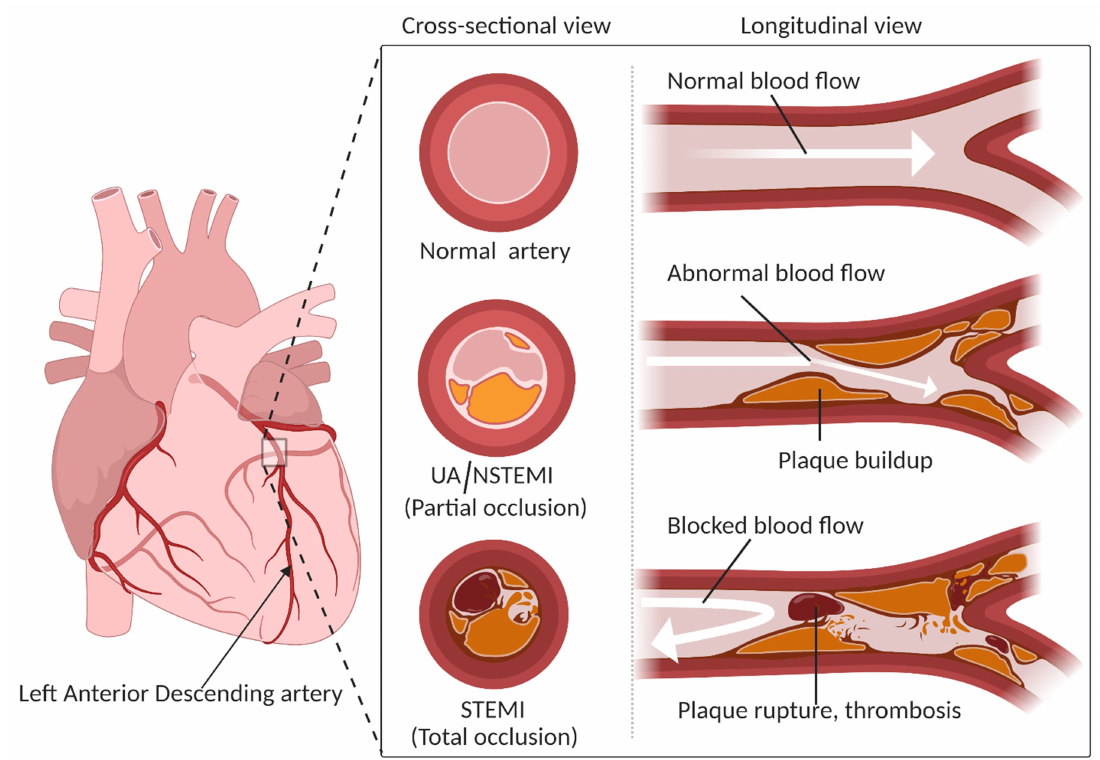
Figure 1. Classification of acute coronary syndromes. Acute coronary syndromes are categorized into unstable angina (UA), non-ST-segment elevation myocardial infarction (NSTEMI), and ST-segment elevation myocardial infarction (STEMI). A complete coronary artery occlusion due to thrombus formation results in STEMI, where the coronary blood flow is completely obstructed. A partial occlusion of the artery (blood flow is not entirely restricted) can result in NSTEMI or